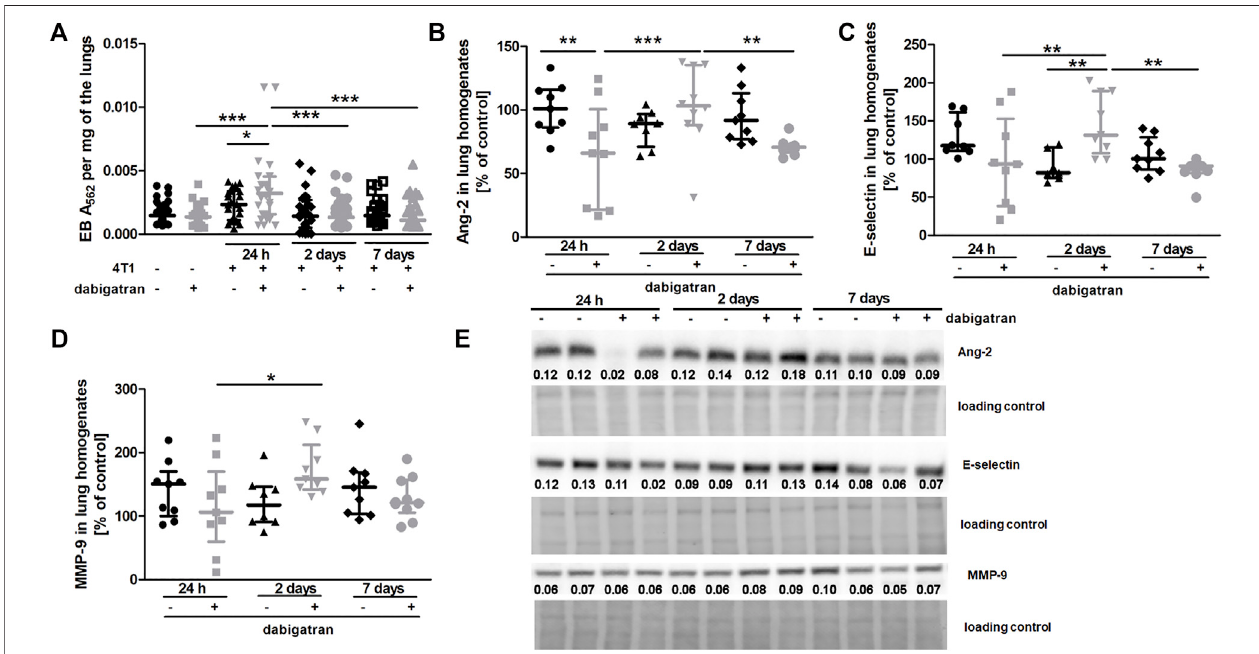
FIGURE 3 | Effects of dabigatran on lung permeability and in fl ammation markers in the lungs of BALB/c mice injected with 4T1 breast cancer cells. Mice were treated with vehicle (black symbols) or dabigatran etexilate (grey symbols) as described in Section 2.5 . (A) depicts retention of Evans blue (EB) in the lung parenchyma, re fl ecting lung permeability. Control mice did not receive cancer cells and were euthanized at the end of the dabigatran pre-treatment to exclude the possibility that dabigatranaffectedpulmonarypermeabilityofhealthy animals before theirinoculation with4T1cancercells. Afterdabigatran/vehiclepre-treatment, theothermice wereinjectedintravenouslywith4T1breastcancercellsorthevehicleandeuthanized24 h,2 days,and7 daysafterinjection. (B – D) showthelevelsofAng-2,E-selectin, and MMP-9, respectively. (E) shows representative Western blot images of Ang-2, E-selectin, and MMP-9 with densitometric data after their normalization to the total protein used as loading control based on the stain-free technique as described in Materials and Methods . For (A – D) , statistical analysis was performed with two-way ANOVAandanappropriateposthoctest.Thesymbols*,**,and***denotestatisticalsigni fi canceat p < .05, p < .01,and p < .001,respectively,andthedataaredepicted as the median ±